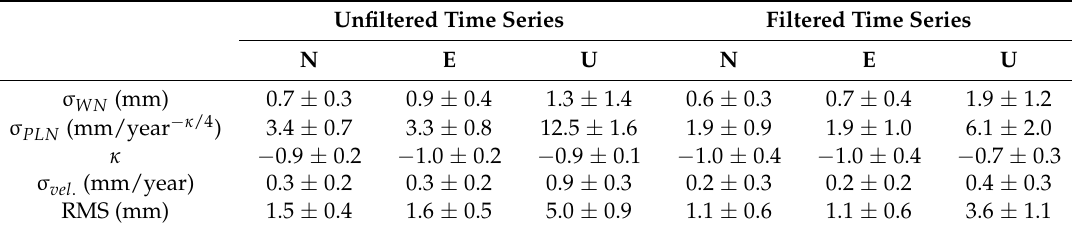
Table 2. Same as Table 1, but for the CMONOC-II time series.